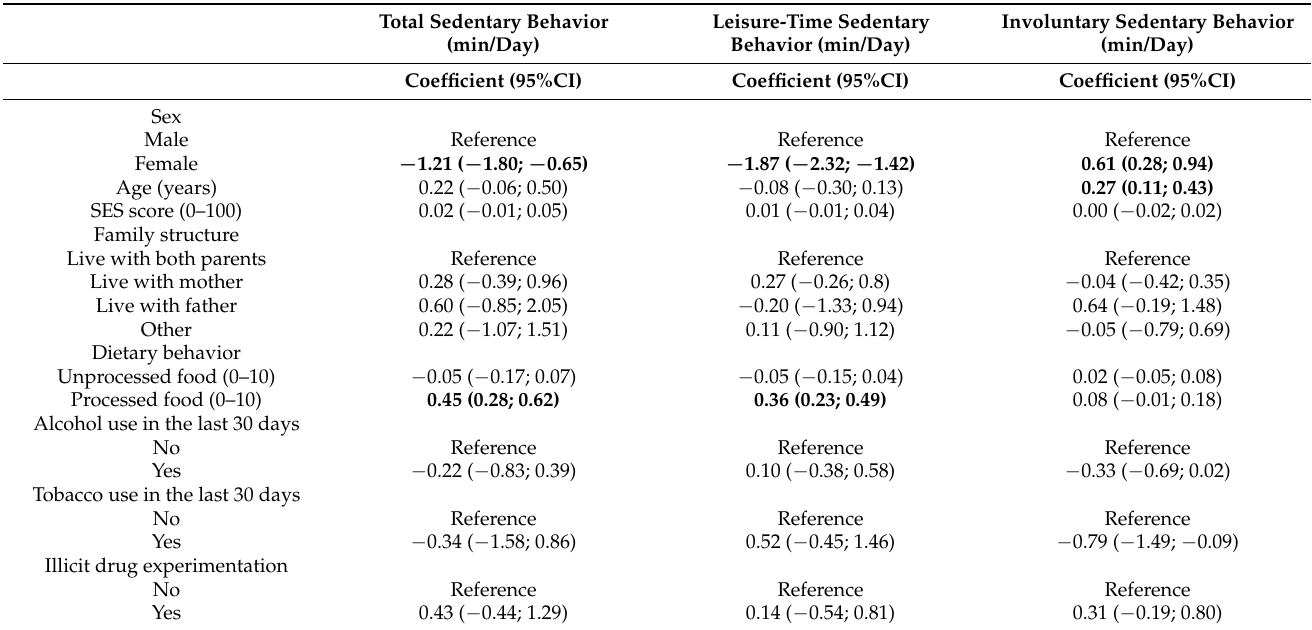
Table 3. Association between sociodemographic, dietary, and substance use factors with total, leisure, and involuntary sedentary behavior in a sample of Brazilian adolescents ( n =